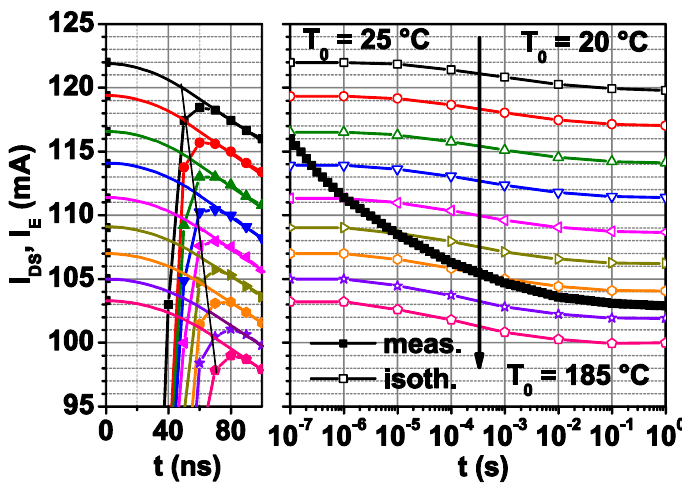
Figure 8. Measured I DS time dependence (full-dot) at T 0 ≈ 25 ◦ C and approximated isothermal I E time dependence (empty-dot) at various T 0 for applied V DS pulse.